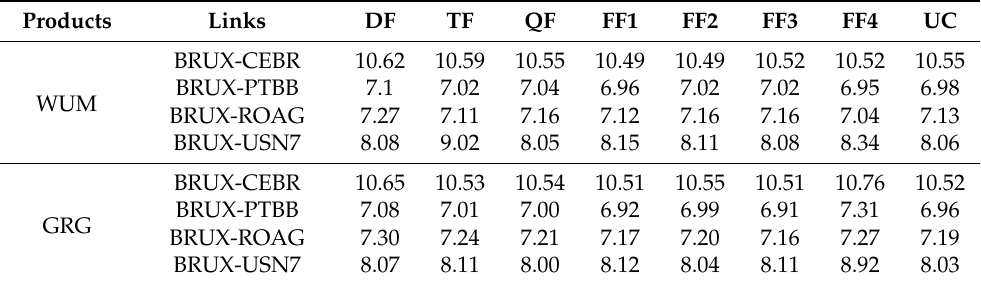
Table 6. Clock offset epoch difference RMS at four time-frequency links by the WUM and GRG product PPP solutions on DOYs 190 to 196 in 2020 (ps).